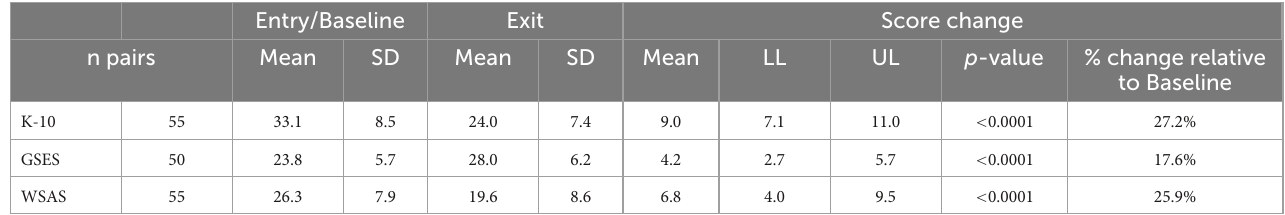
TABLE 2 Summary of scores on: Kessler Psychological Distress Scale (K-10), General Self-Efficacy Scale (GSE), and Social and Work Adjustment Scale (WSAS)–Entire sample ( n =